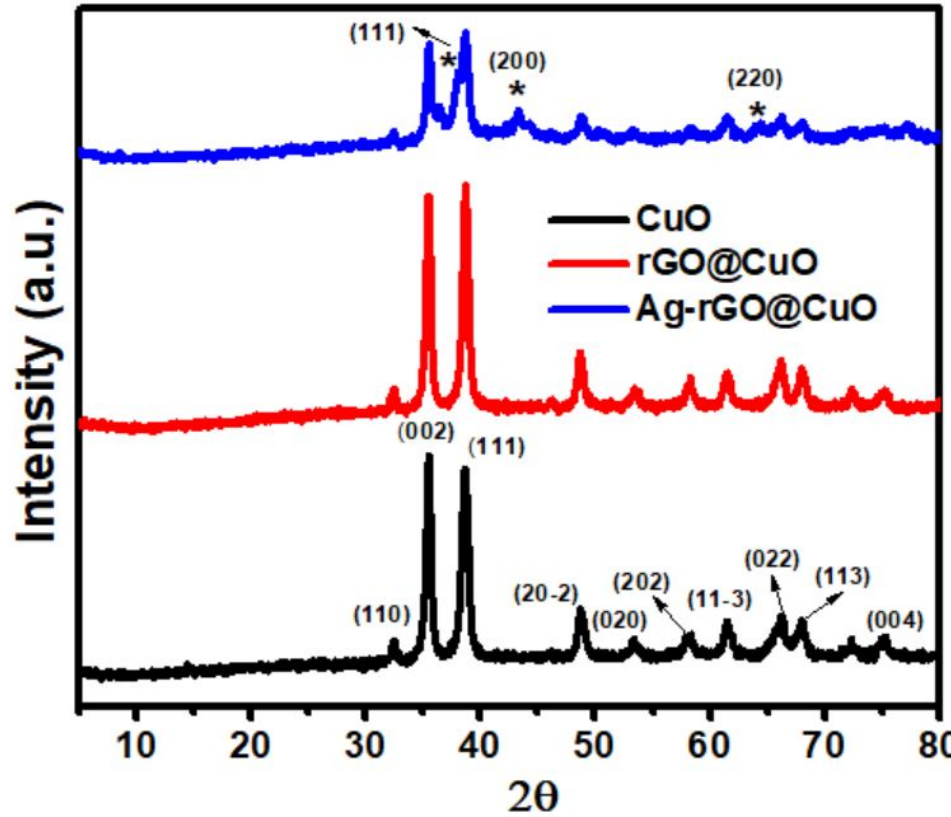
Figure 2. XRD pattern of pure CuO nanosheets, rGO@CuO, and Ag-rGO@CuO nanocomposites. The asterisk (*) represents the peak positions of Ag.